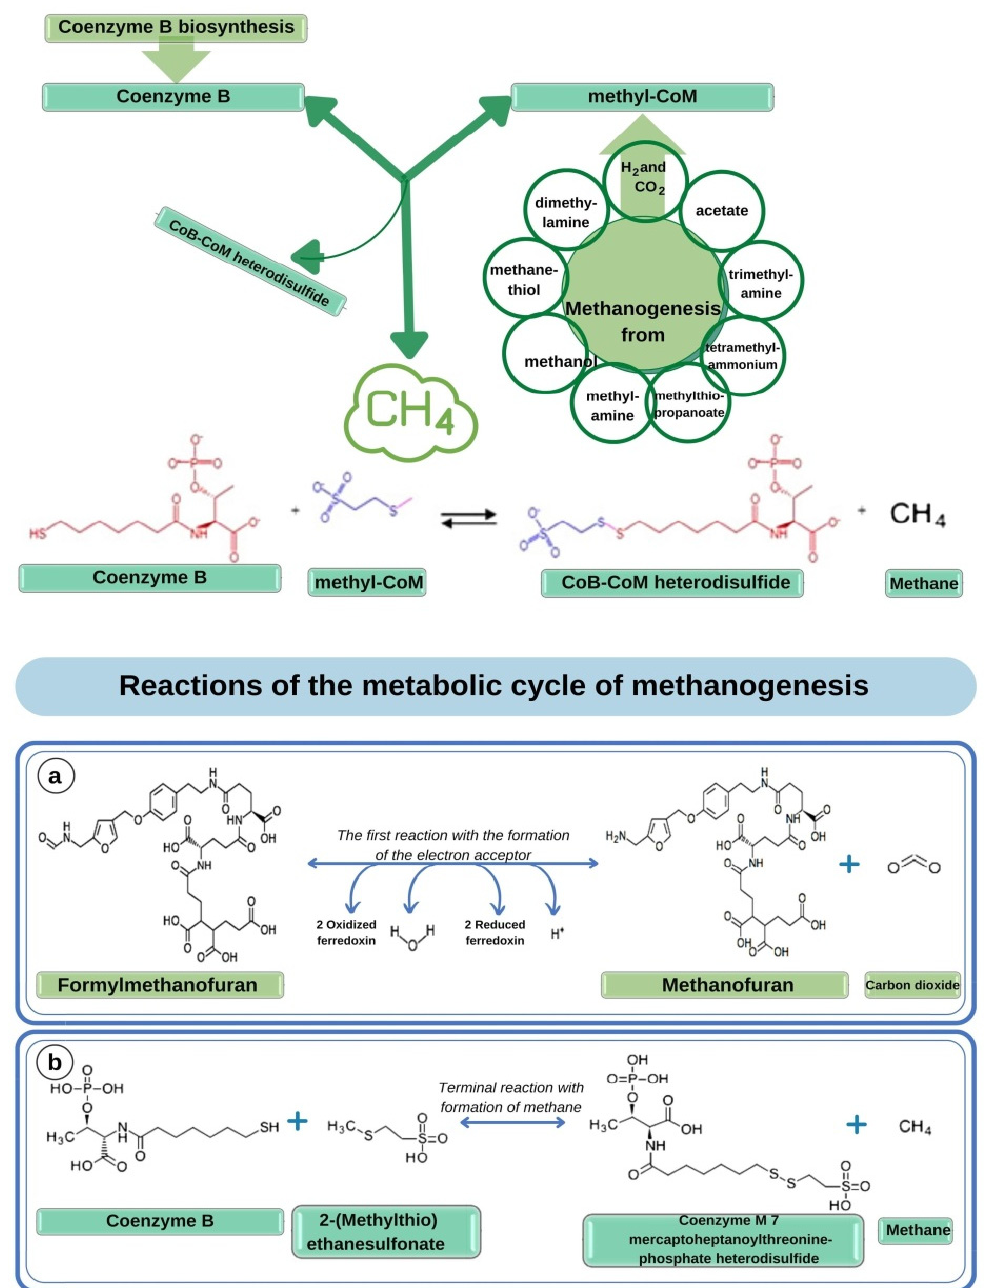
Figure 6. Summary model of metabolic pathways of methanogenesis: ( a ) the first reaction with the formation of the electron acceptor CO 2 ; ( b ) terminal reaction with formation of methane.